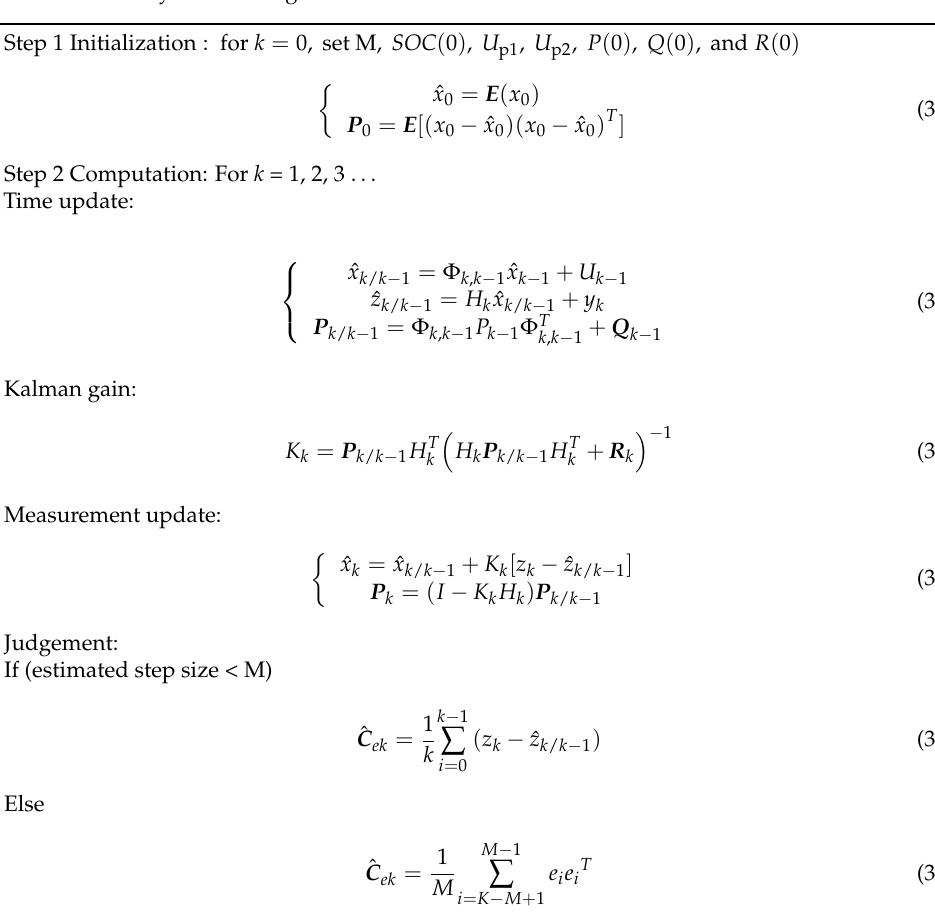
Table 2. Summary of AEKF algorithm based on